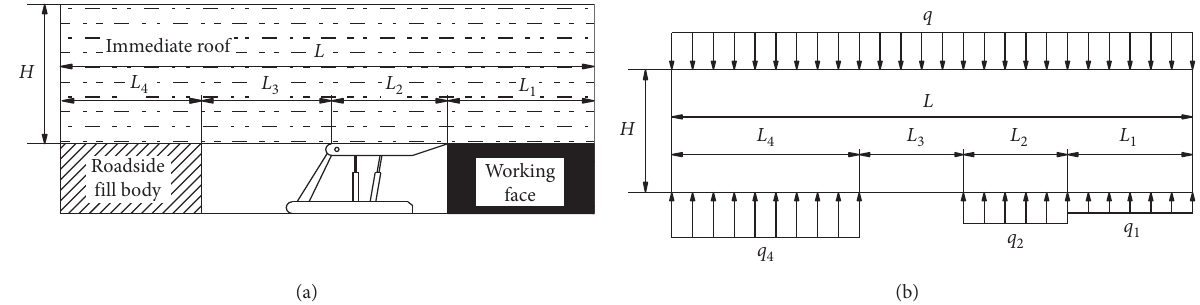
Figure 2: Mechanical model of immediate roof stability analysis above the roadside filling area in GER-RF. (a) Section of GER-BB along the strike direction. (b) Immediate roof mechanical model in GER-RF along the strike direction.